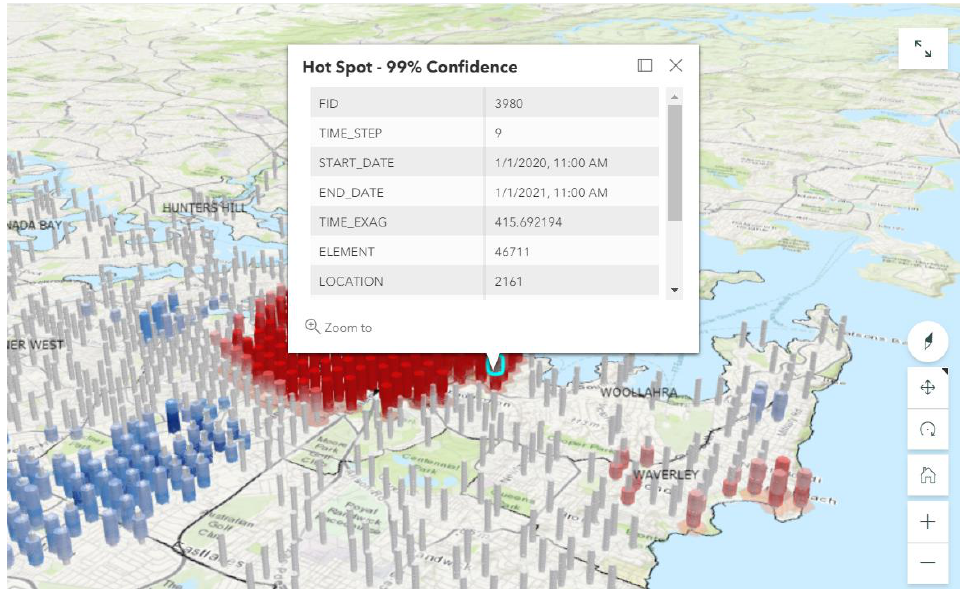
Figure 24. Storymap user interface.